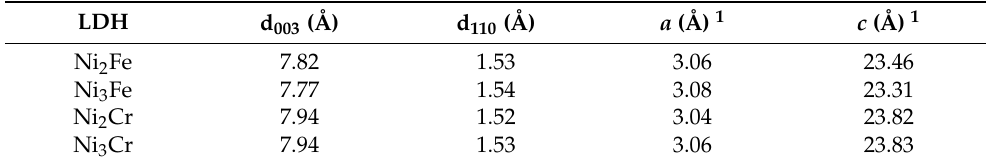
Figure 1. XRD patterns of Ni R Cr ( a ) and Ni R Fe ( b ) LDH precursors. Table 1. Structural parameters of Ni R Fe and Ni R Cr LDH precursors obtained from XRD patterns.